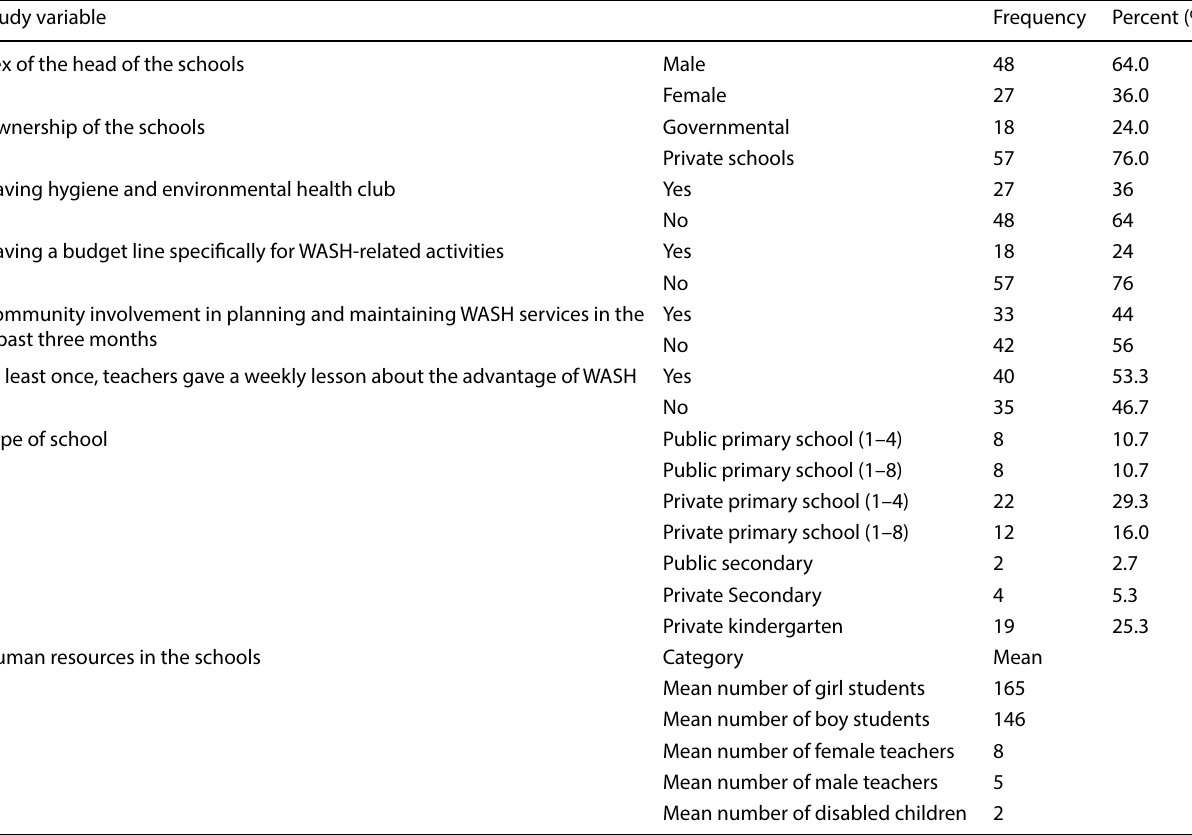
Table 1 Sociodemographic characteristics of the schools Study variable